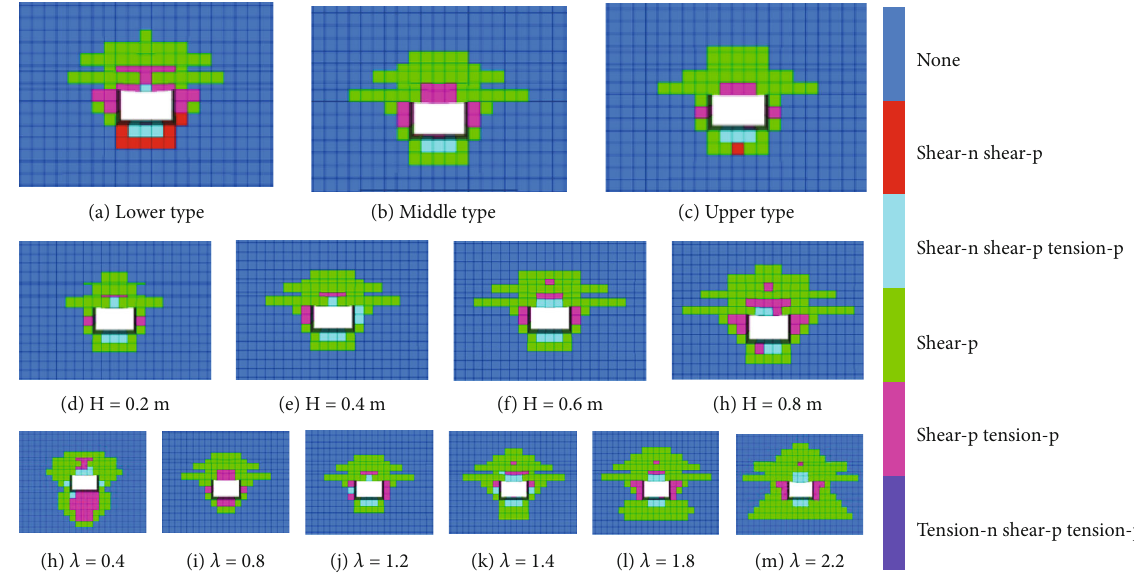
Figure 3: Distribution of plastic zone in coal roadway with composite roof under di ff erent in fl uencing